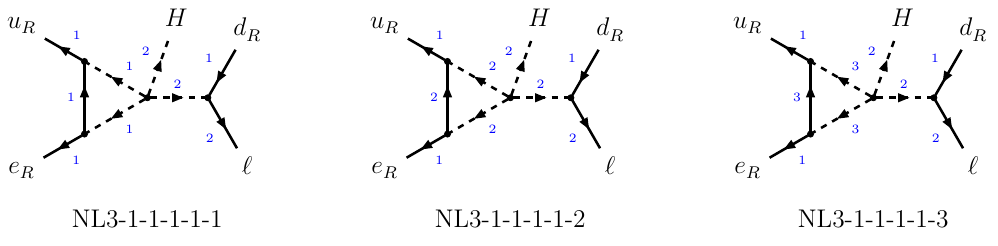
quantum numbers for the diagram L